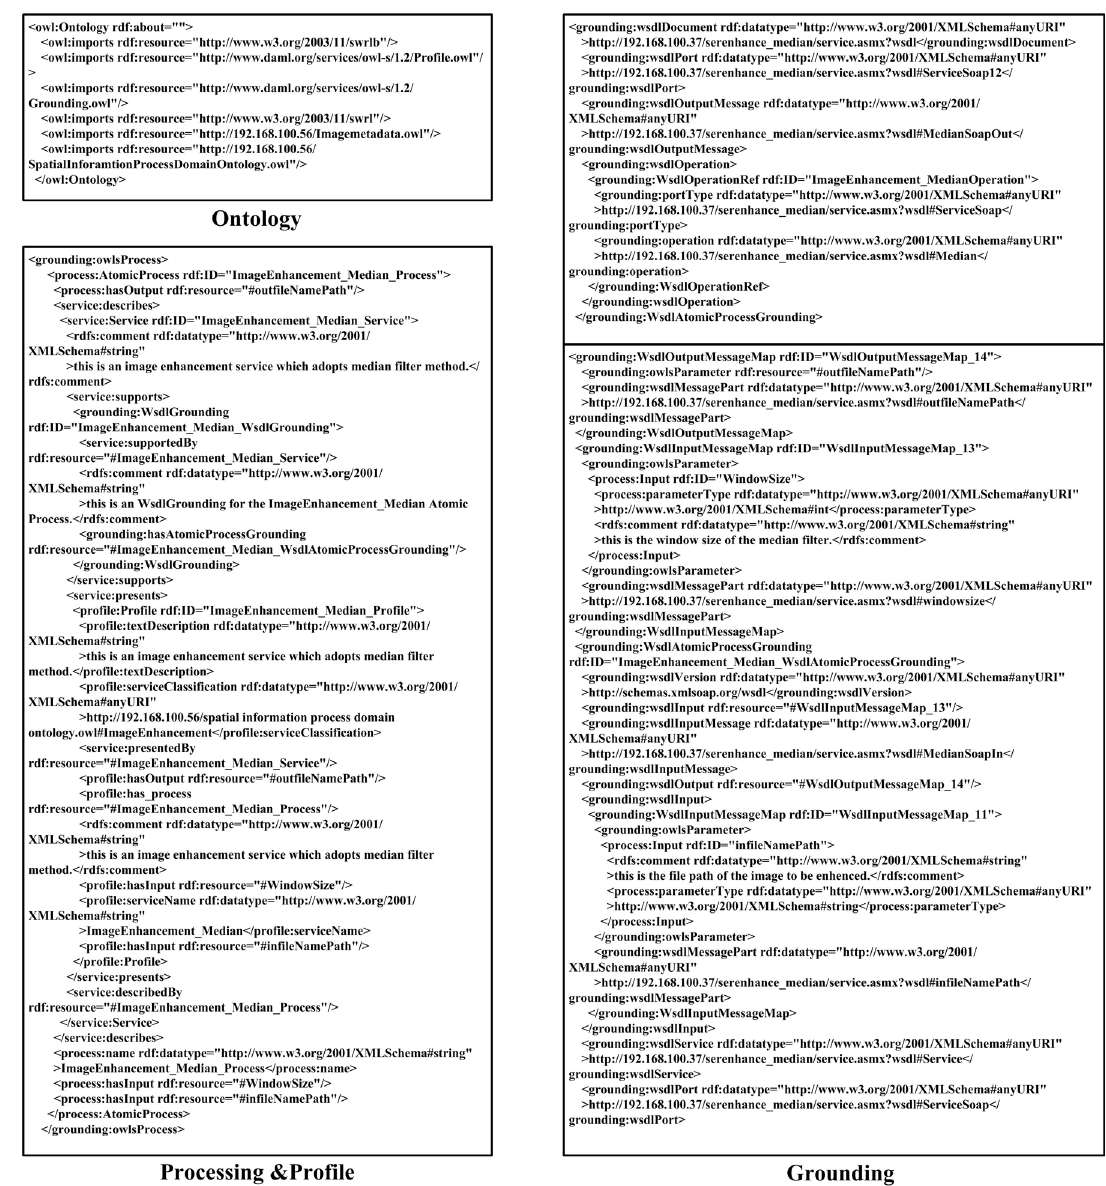
Figure 8. An example of the OWL-S